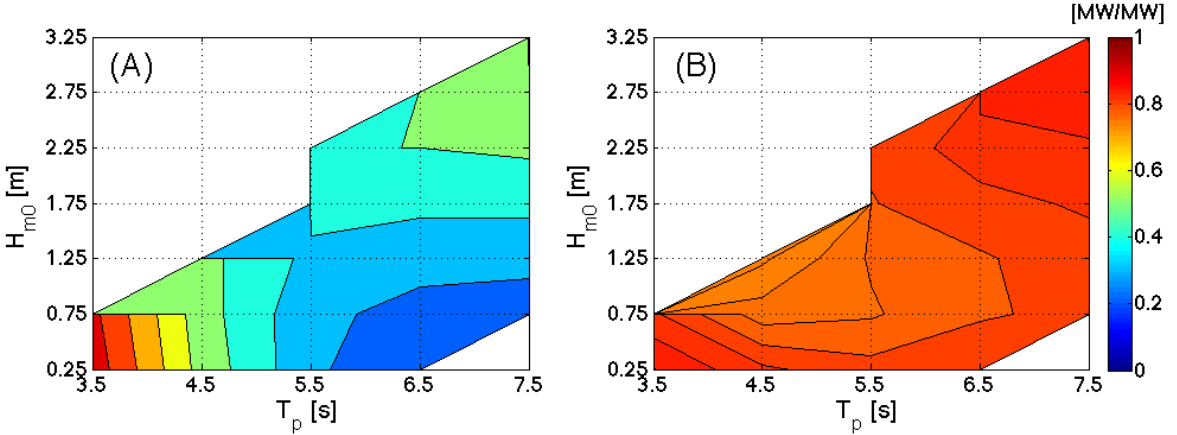
Figure 6. Comparison of P and PI controller power performance normalised by the MPC results, for constrained case (Case 3): ( A )—P controller power matrix Case 3; ( B )—PI controller power matrix Case